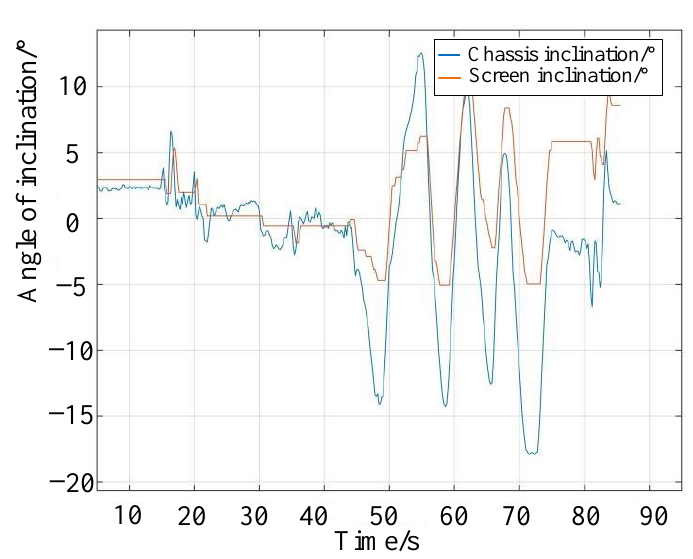
Figure 10. Tracking effect test results.